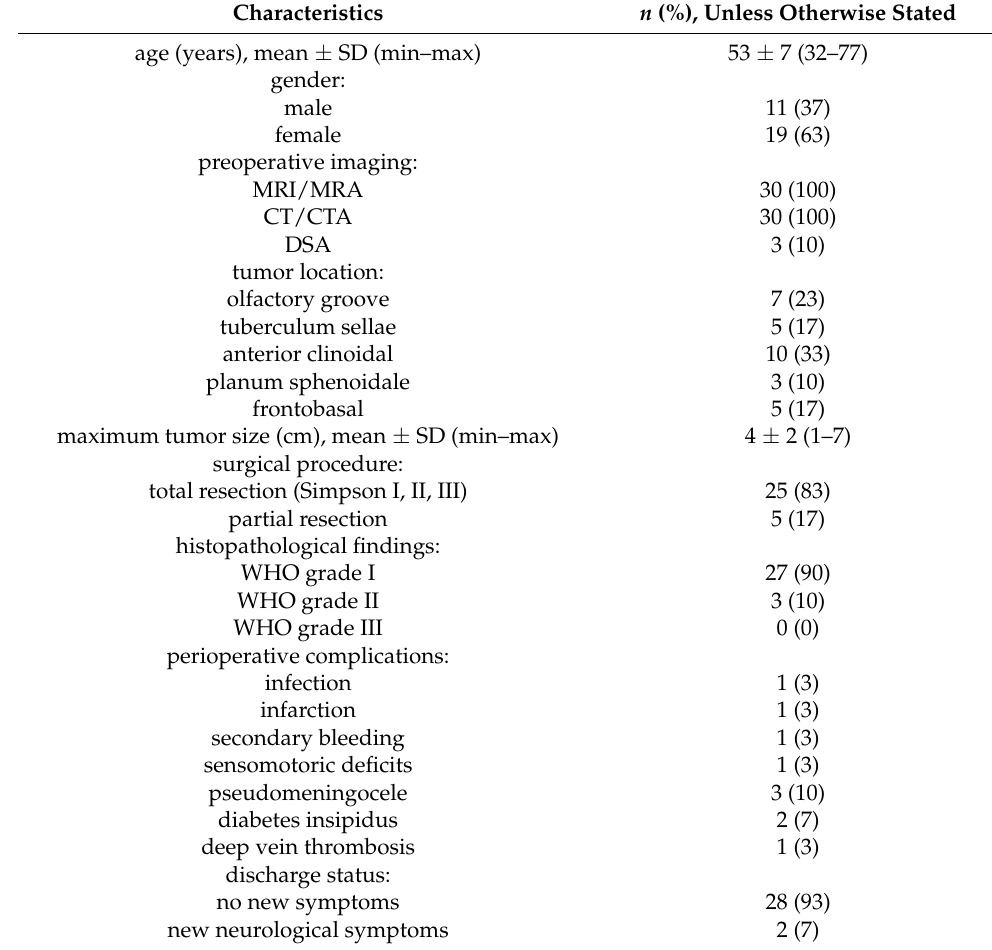
Table 2. Patient- and disease-related data of included patients with anterior skull base meningiomas. One or more complications per patient were